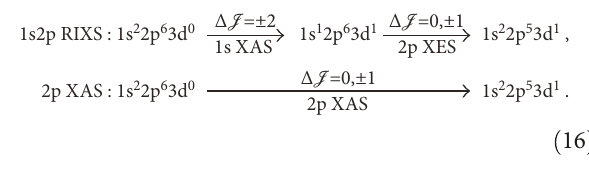
Figure 8: Splitting of the intermediate state spin singlet and triplet terms 1,3 D due to 3d SOC ζ States accessible in 1s XAS ( J = 2 ) are shown in blue. However, the existing terms with J = 1 or 3 cannot be populated and will therefore not contribute to the spectrum.